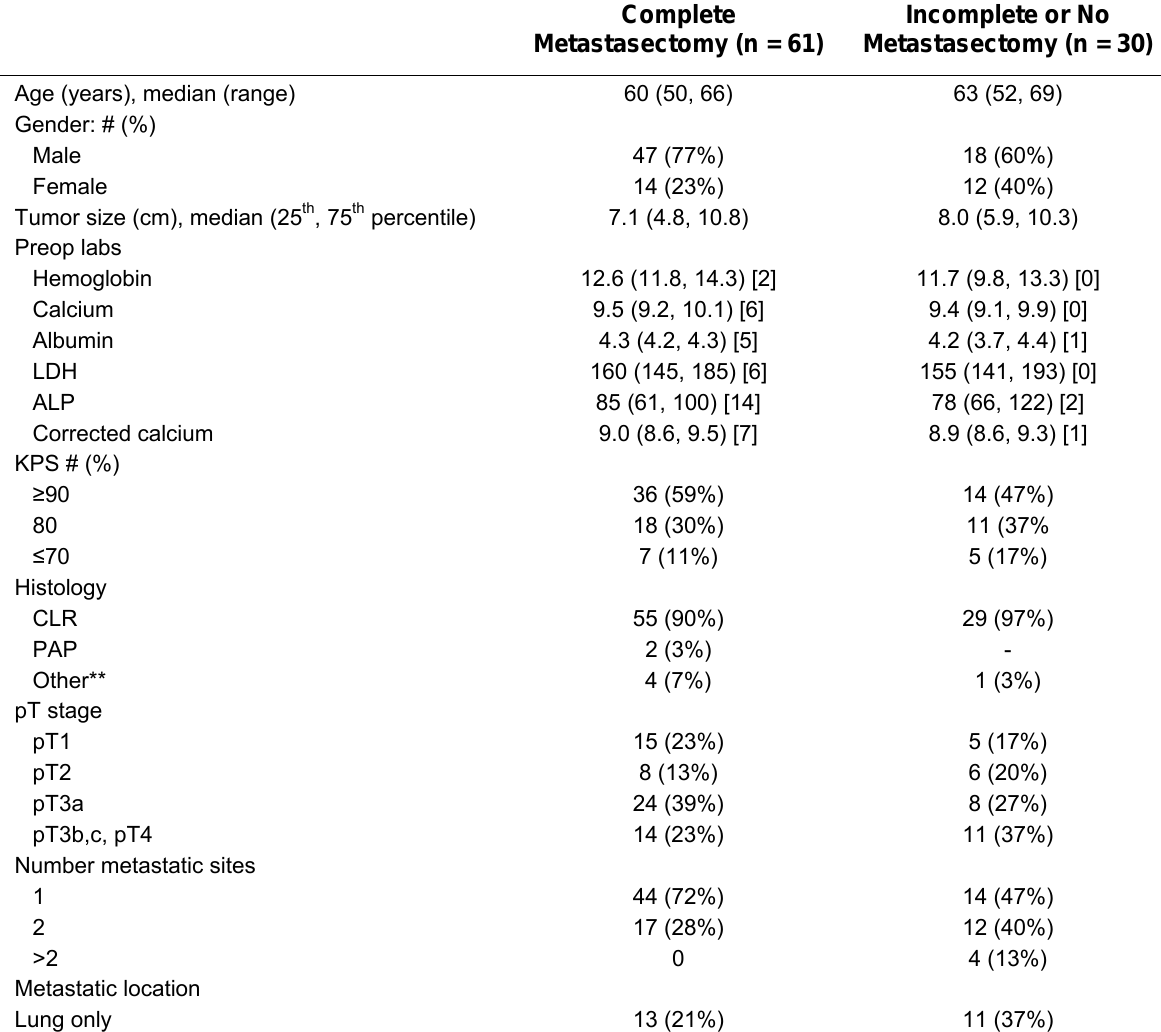
Clinical Characteristics of Patients by